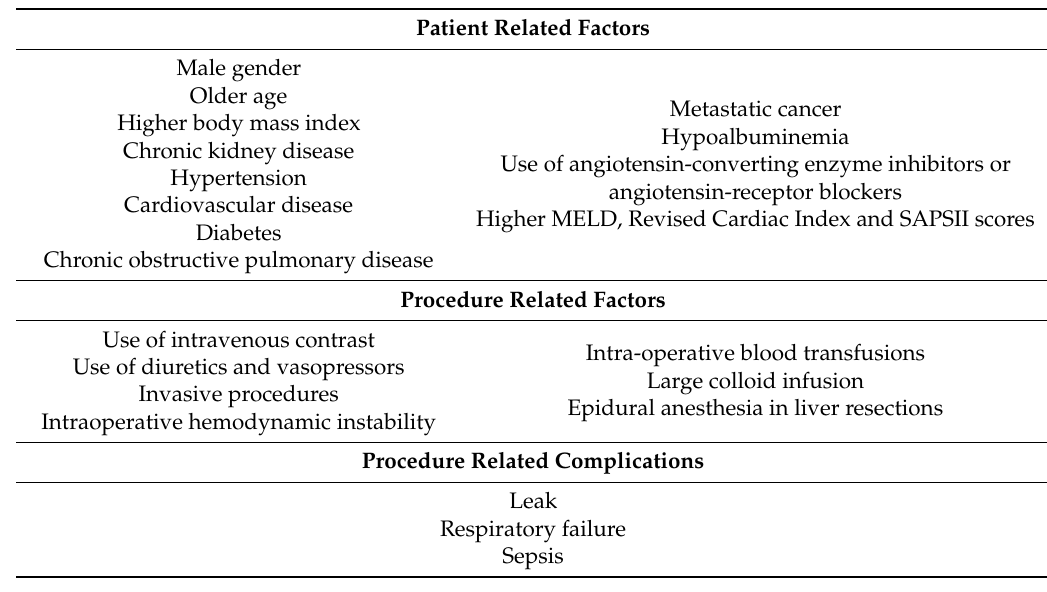
Table 1. Risk factors for AKI after major abdominal